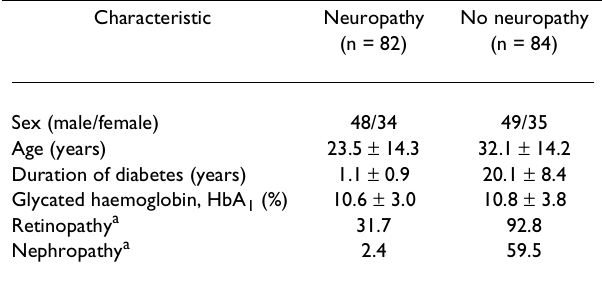
Table 1: Clinical characteristics of the patients Characteristic